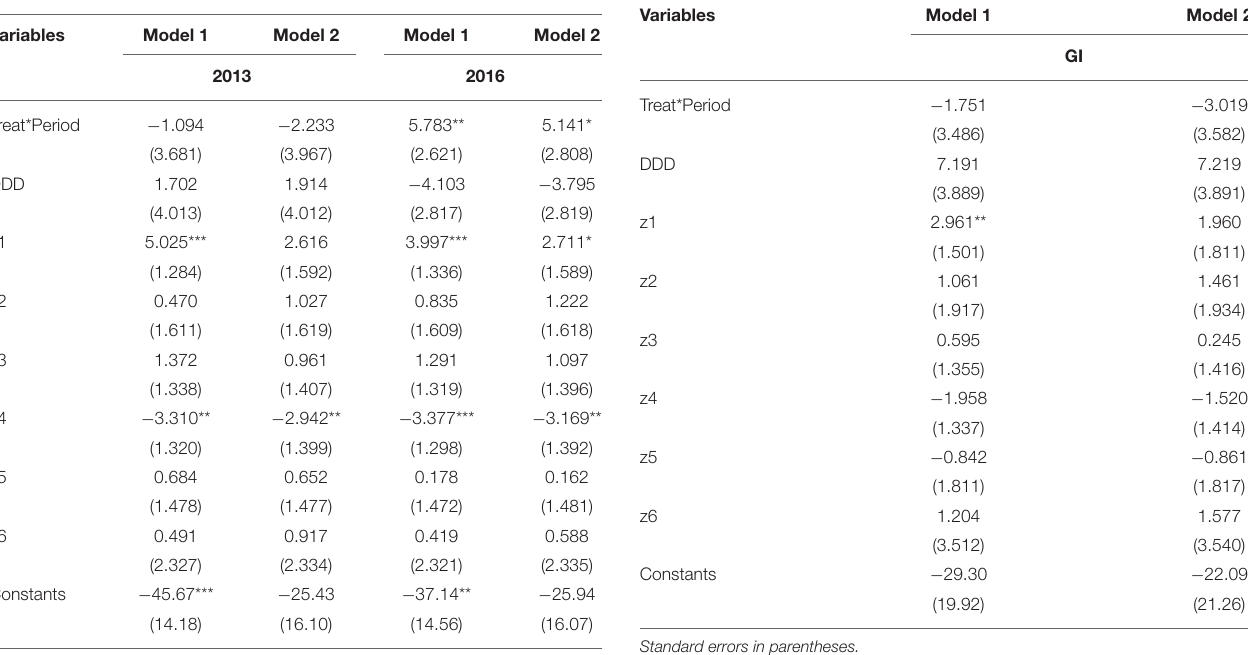
TABLE 7 | Placebo tests that adjust the implementation time of the EPL to 2013 and 2016.